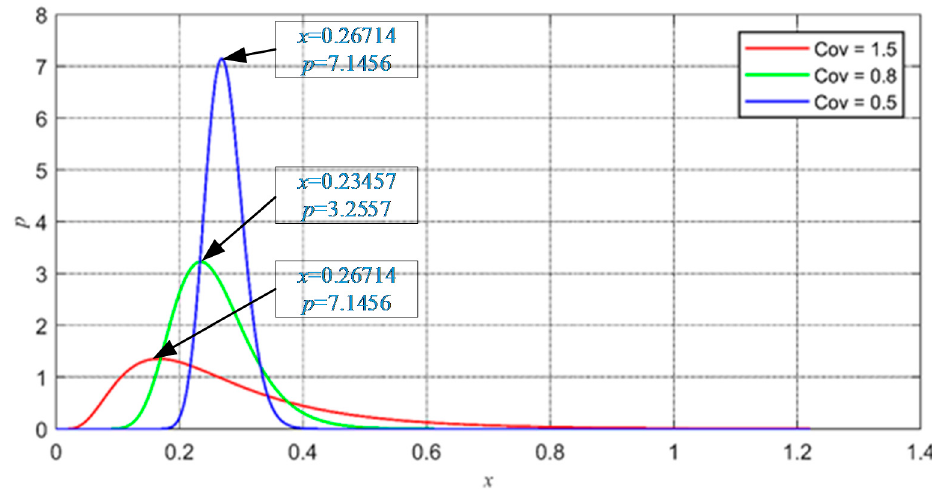
Figure 16. PDF curves of saturated hydraulic conductivity.